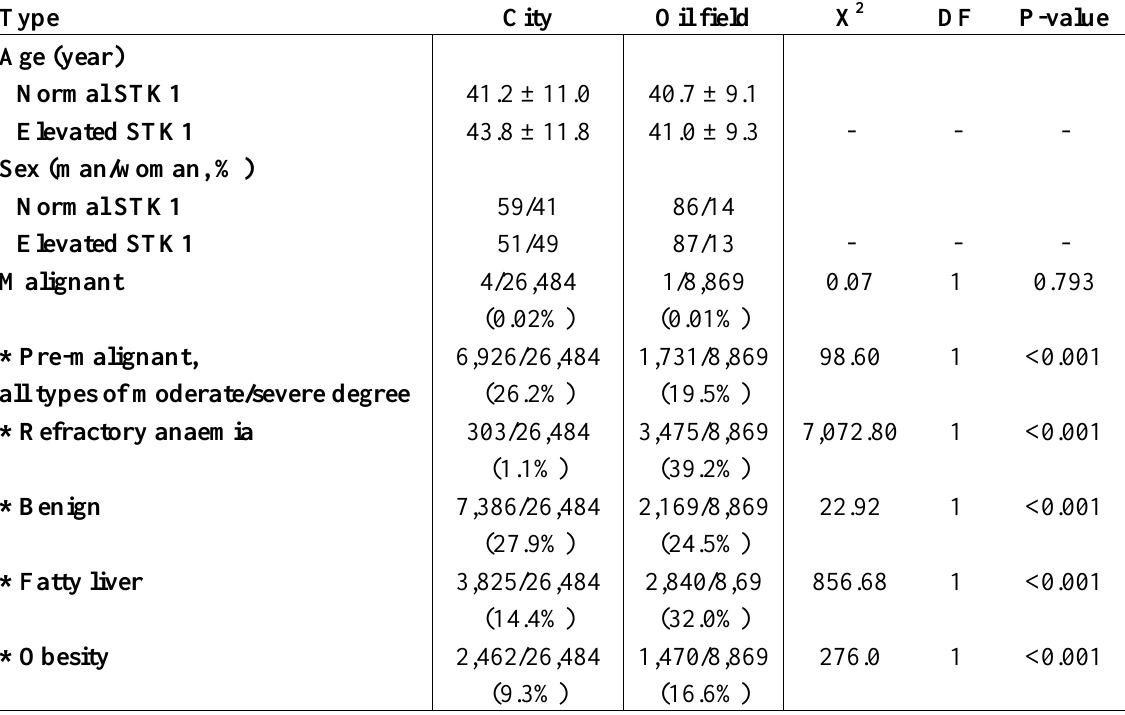
Table 1. Characteristics of citydwellers and oilfield workers with diseases linked to development of malignancies. The statistical calculations were done by chi-square test. The star ( * ) indicates groups of statistically significant